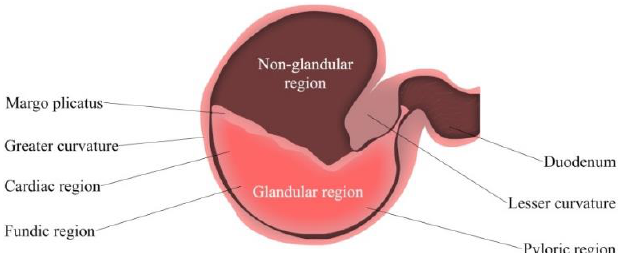
Figure 2. Simplified Isolated Stomach of the adult horse. From left to right: Fundic (upper region)